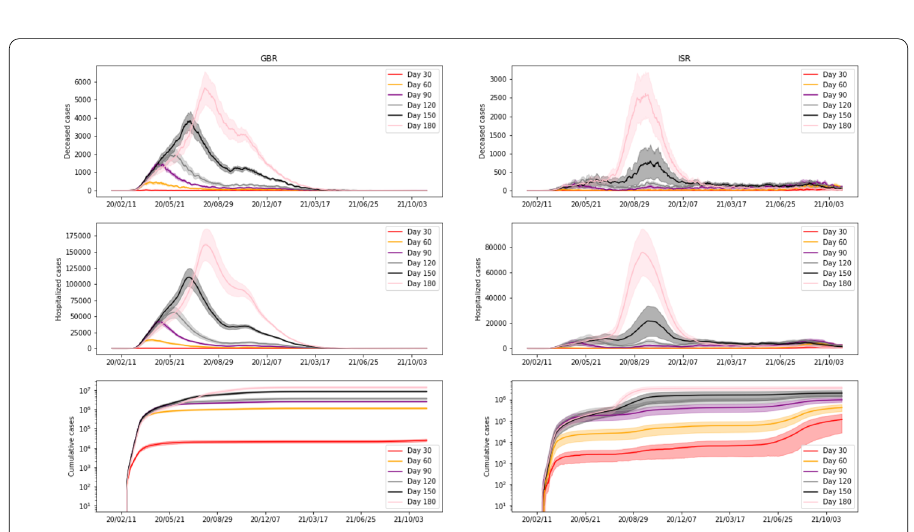
Figure 13 Scenario9 . Comparison of simulations with different starting day of test campaign, without alterations on tracing and testing policies. We present cumulative cases, hospitalized and deceased for both GBR (on the left) and ISR (on the